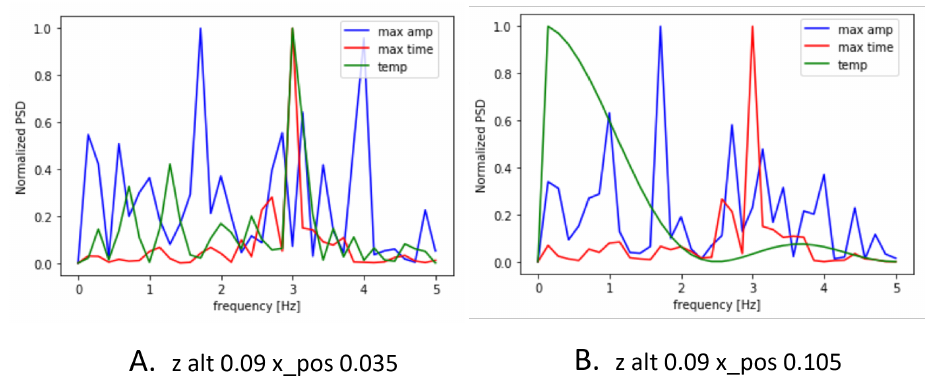
Figure 9. History and PSD analysis for temperature, time of flight and wave